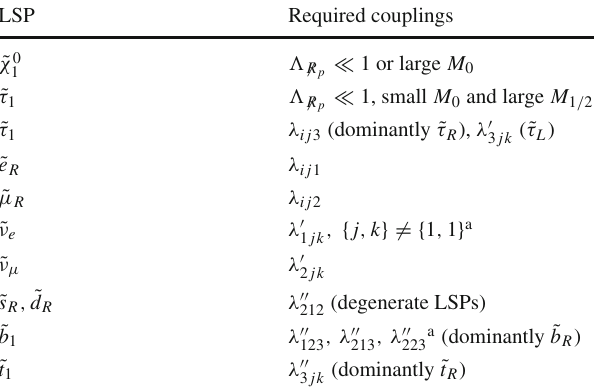
Table 2 Summary of the various LSP scenarios in the (cid:6) (cid:5) R as a function of the dominant necessary RPV coupling at M X . a Note that the couplings on the right column are required but their presence is not necessarily sufficient to get the corresponding LSP. The couplings λ (cid:4) , λ (cid:4)(cid:4) and λ (cid:4)(cid:4) are too constrained to produce an LSP of that kind; 111 112 113 see Table 13 LSP Required